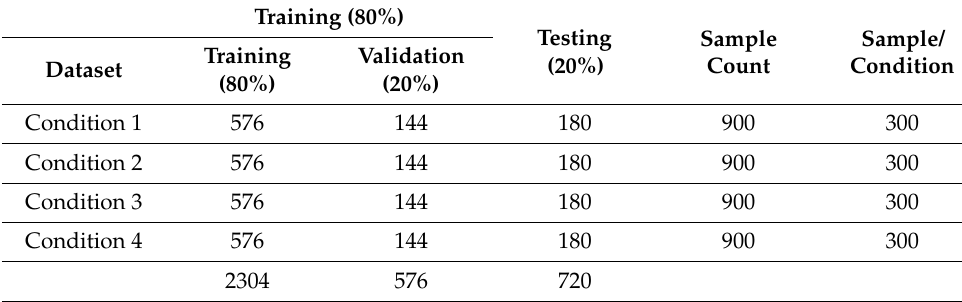
Table 4. The splitting ratio of the dataset into training, validation, and test